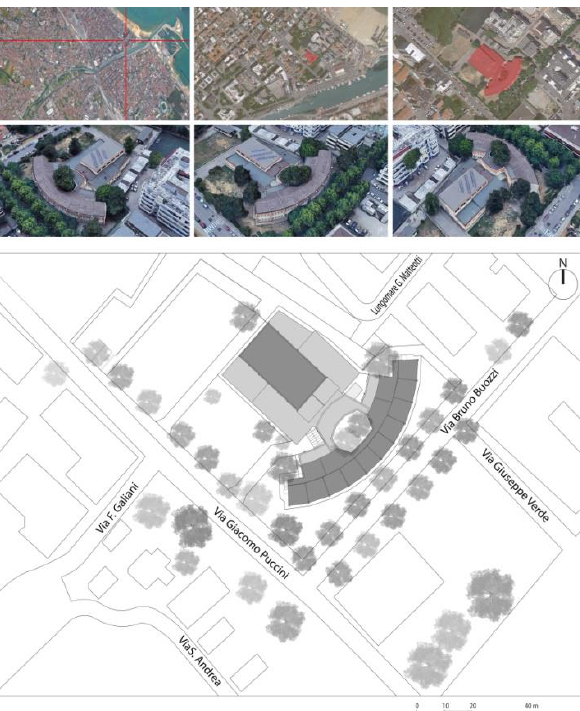
Figure 4. Localization and acquisition of drone photo-data from the Borgomarino school.